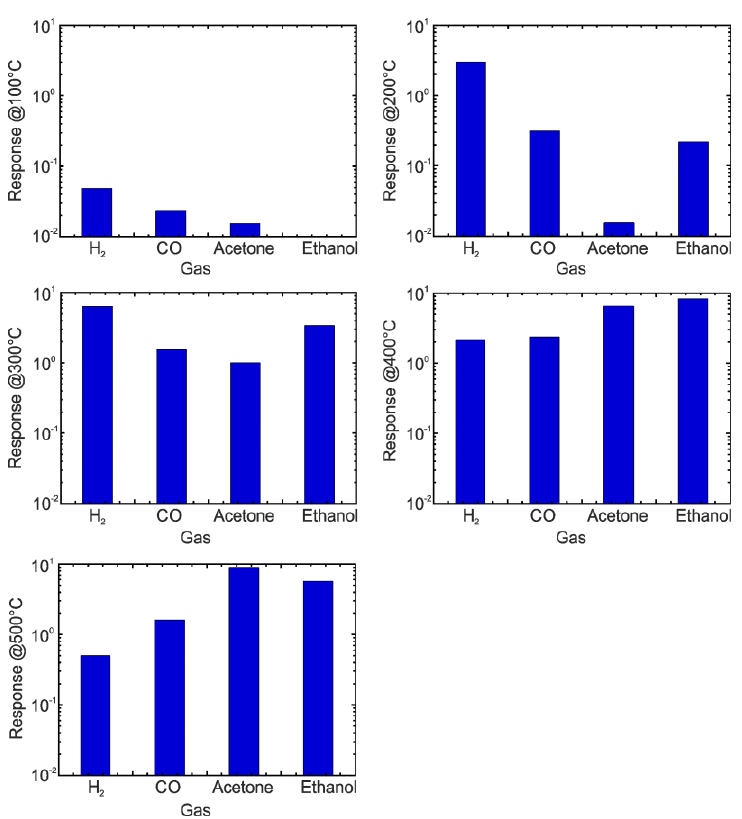
Figure 13. The response of niobium-containing TiO 2 nanotubes towards 500 ppm of H 2 , 500 ppm of CO, 50 ppm of acetone and 50 ppm of ethanol at different operating temperatures (100, 200, 300, 400, 500 °C) with 40%RH @20 °C. Reproduced with permission from [20]. Copyright (2014) Elsevier B.V.